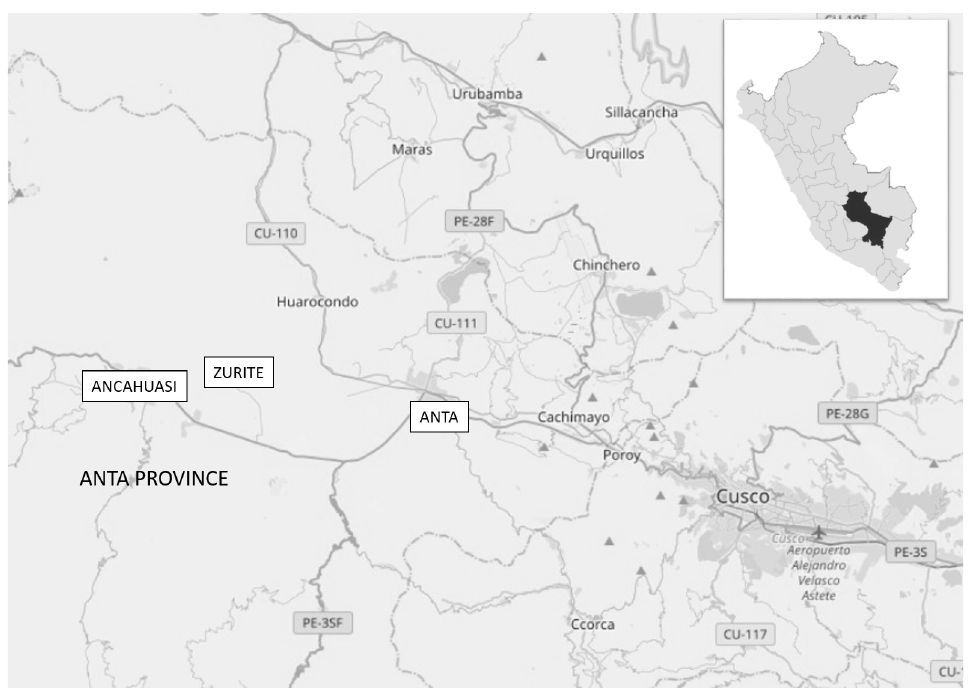
Fig 1. Map of the three districts included in the study (This map was created using Natural Earth http://www. naturalearthdata.com/about/terms-of-use/).